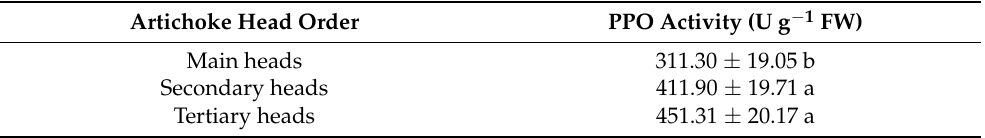
Table 5. Polyphenol oxidase activity (U min − 1 g − 1 ) for different artichoke head orders (main, secondary, and tertiary heads) of ‘Lorca’